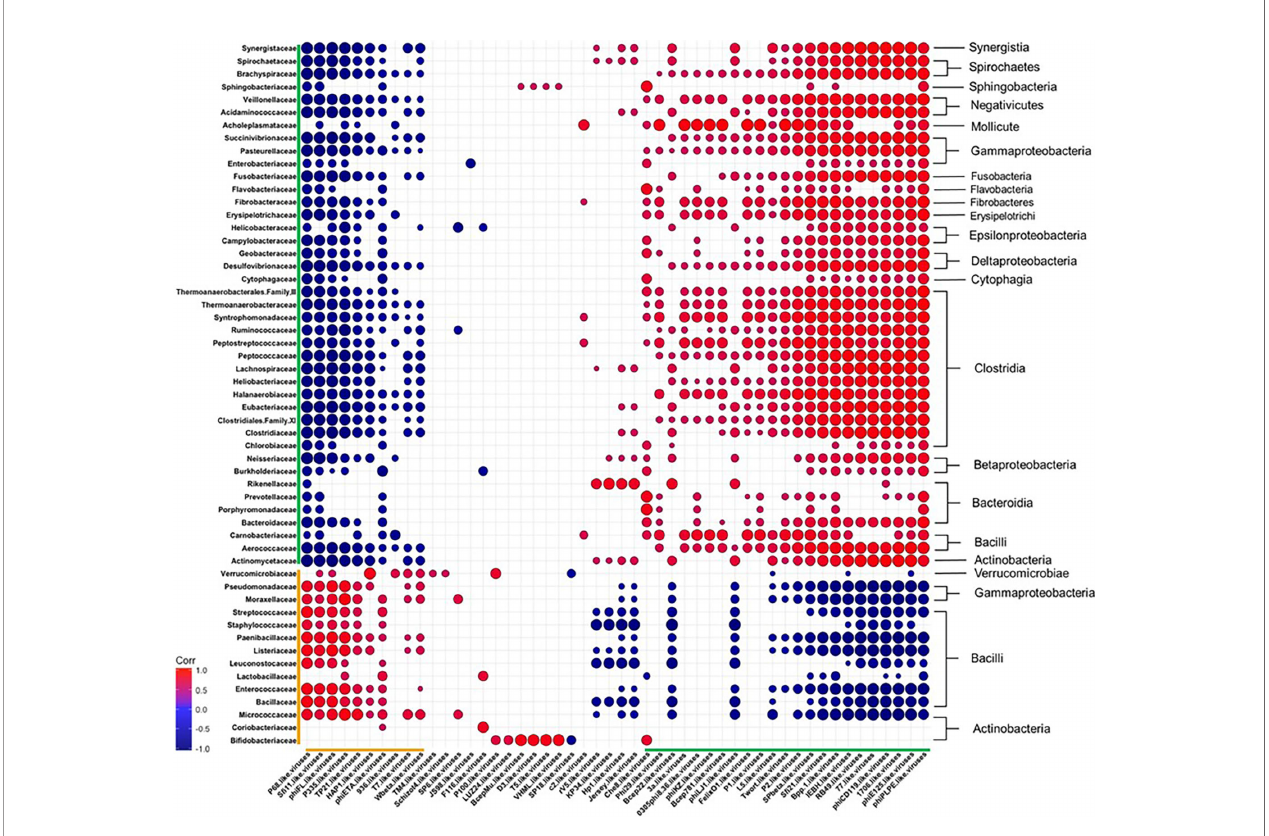
FIGURE 7 | Diet Induced Bacteria-Bacteriophage Patterns in Obesity. Pearson ’ s correlation plot of the top 55 most abundant Bacterial Families and all Bacteriophage Genera (Viral OTUs within the order Caudovirales) for mice fed Chow or WD at 12 weeks. Positive values (red circles) indicate positive correlation coef fi cients above 0.6, and negative values (blue circles) indicate inverse correlation coef fi cients below -0.6. The size and shading of the circles indicate the magnitude of the correlation, where darker shades indicate a stronger correlation than lighter shades. Organization of the plot is based on the correlation coef fi cient values of Brachyspiraceae. Correlation coef fi cient values outside of the threshold of 0.6 are not included in this plot, but are outlined in Table S9 . Putative host information and correlation coef fi cient values between bacteriophage genera and putative bacterial host family are listed in Table S8